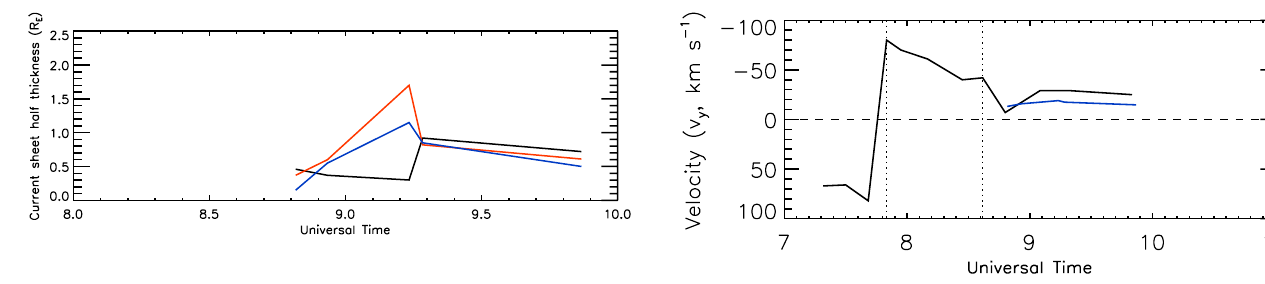
Fig. 14. Plot of the velocity in the Y direction (black), determined from four-spacecraft analysis, for the dipolarization and wave fronts against time and the phase velocity calculated from the Erkaev et al. (2008) model using the observed current sheet half-thicknesses and a wave period of 20min. The dashed lines indicate the times of the